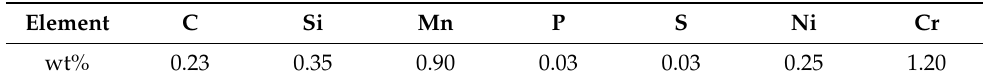
Figure 3. Steel hub insert. Table 3. Chemical composition of SCR420.